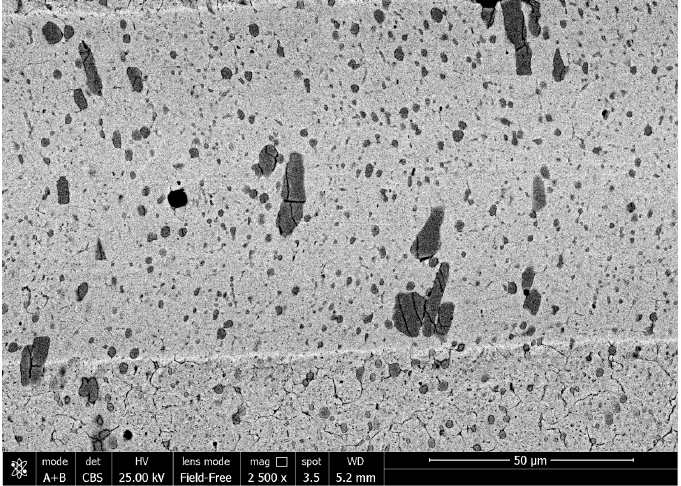
Figure 4. SEM micrograph of the scratch on the AISI D2 ‐ C sample.